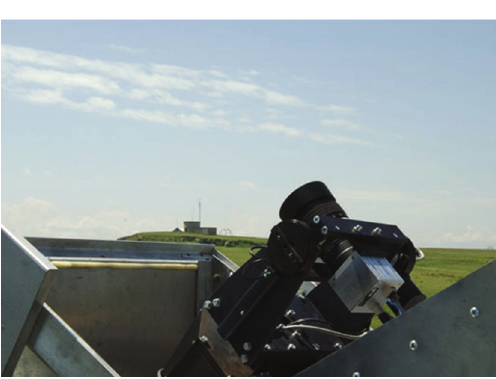
Figure 5: MASTER very wide-field camera.